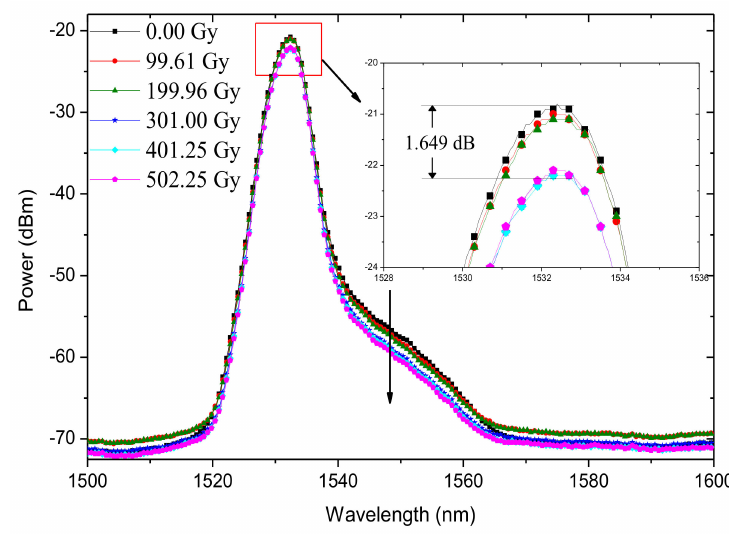
Figure 9. Spectral evolution of SFS#4 in increased radiation dose.